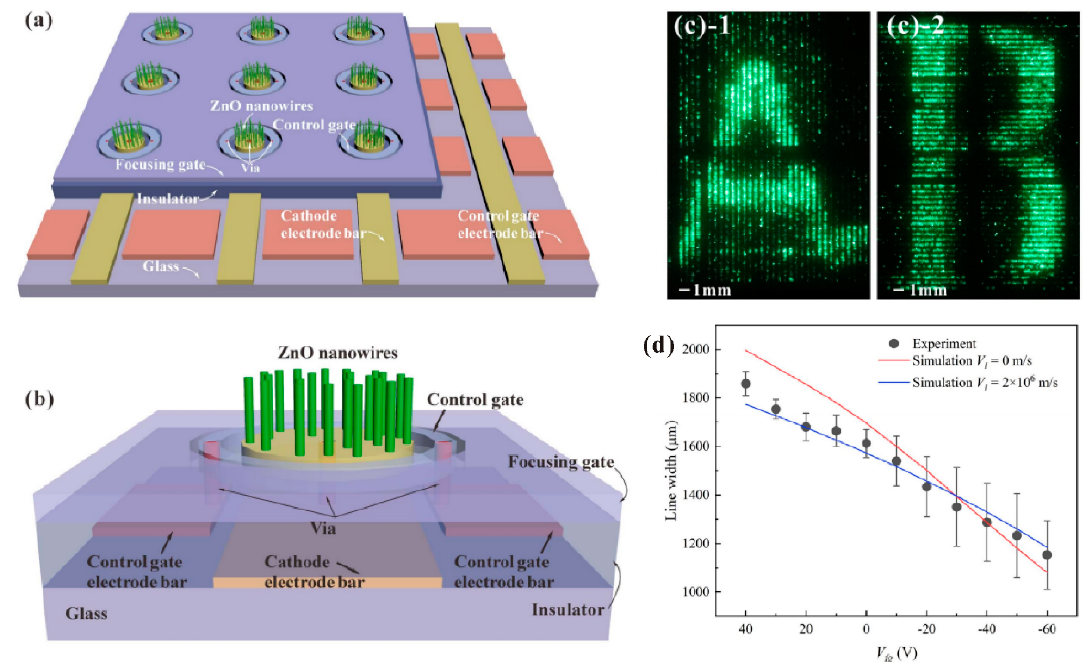
Figure 31. Demonstration of an addressable gated field-emission device with focusing gate based on ZnO nanowires. Schematic diagram for multi ( a ) and one ( b ) pixel of the device structure. English characters of “A” ( c-1 ) and “B” ( c-2 ) displayed by the device. ( d ) The relationship between the line width on the phosphor anode of one row pixels and the focusing gate voltage. Reproduced from [37], with the permission of IEEE, 2019.